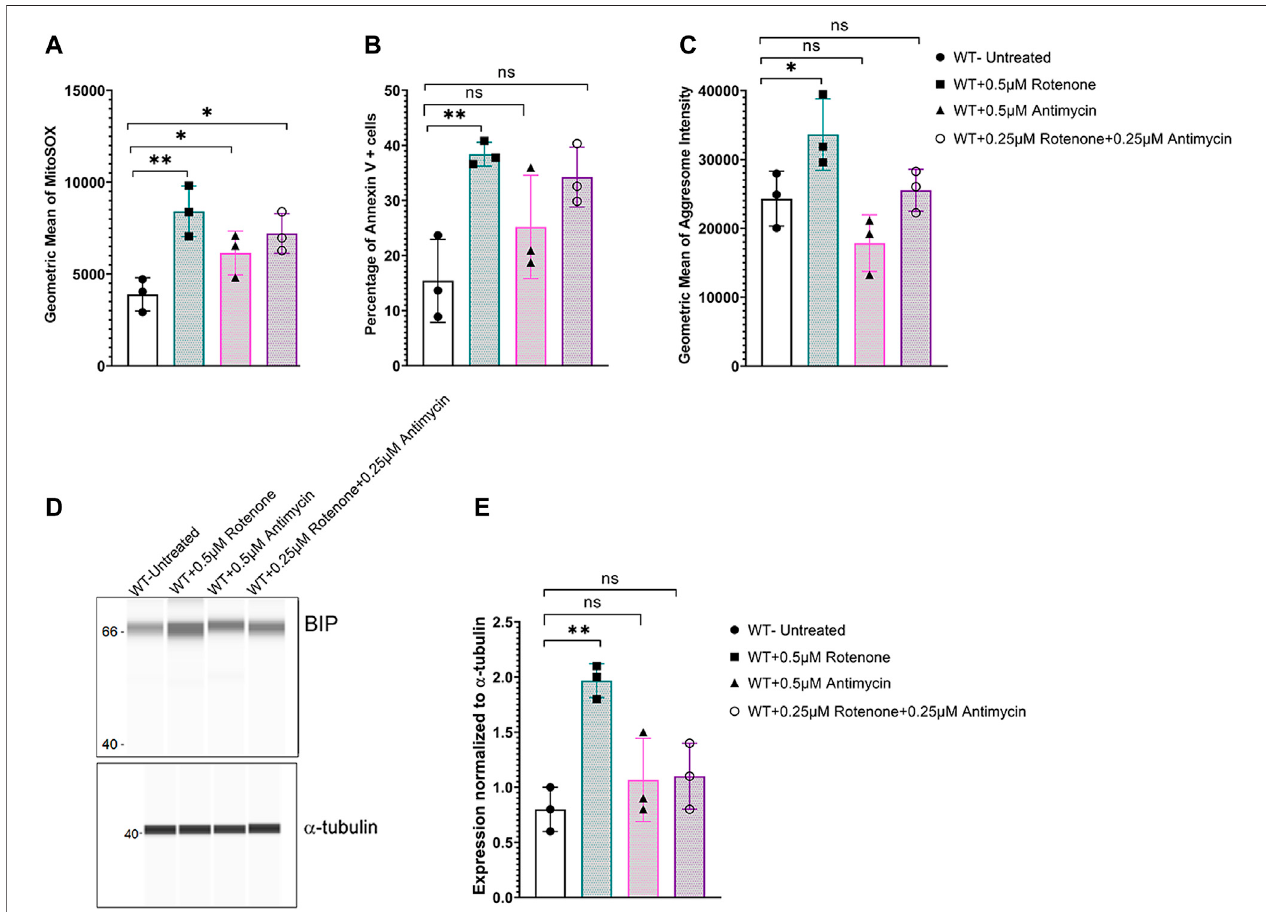
FIGURE 5 | Mitochondrial ROS induces ER stress in Slc4a11 WT MCEC. Cells were treated with 0.5 μ M Antimycin, 0.25 μ M each of rotenone and antimycin, or 0.5 μ M Rotenonefor18 h. (A) Flowcytometry analysisofmitochondrial oxidative stressusing MitoSox staining.N=3.* p < 0.05,** p < 0.01. (B) Flow cytometry analysis of apoptotic cells using Annexin V staining. N= 3, ** p < 0.01, ns-not signi fi cant. (C) Flowcytometry analysisto detect the presence of aggresomes. N =3, * p < 0.05, ns- not signi fi cant. (D,E) Wes immunoassay for BIP and quanti fi cation. N = 3, * p < 0.05, ns-not signi fi cant.